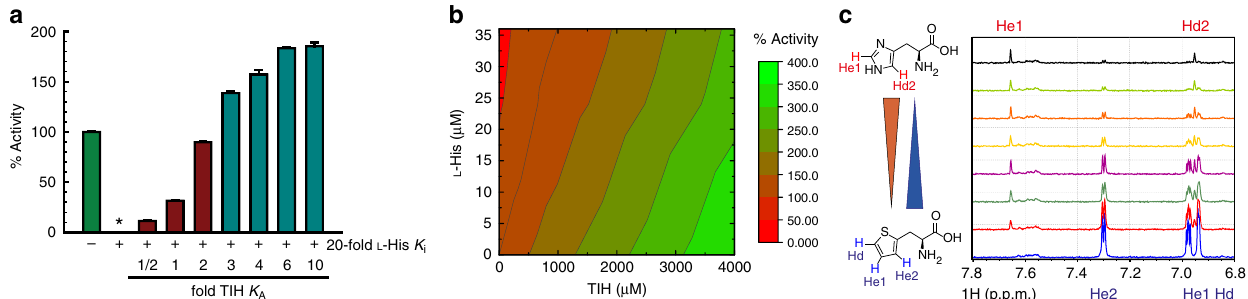
Fig. 4 Competition between TIH and L -His. a ATP-PRT activity in the absence of L -His ( green bar ), in the presence of an L -His concentration equivalent to 20-fold K i (0.4 mM; star ) and in the presence of 0.4 mM L -His plus increasing concentrations of TIH ( dark red and cyan bars , K A = 2 mM). Error bars indicate the s.d., n = 3. b Contour plot of ATP-PRT activity landscape in the presence of both L -His and TIH. c STD-NMR of TIH and L -His with 20 μ M ATP-PRT. TIH concentration was kept at 400 μ M, while the concentration of L -His was varied, 0, 50, 100, 150, 400, 800, 1600 and 3000 μ M, from the blue bottom trace, to the black top trace. Experiments were performed in 50 mM sodium phosphate buffer at pH 8.0. Red and n avy blue triangles indicate ATP-PRT occupancy by L -His and TIH, respectively